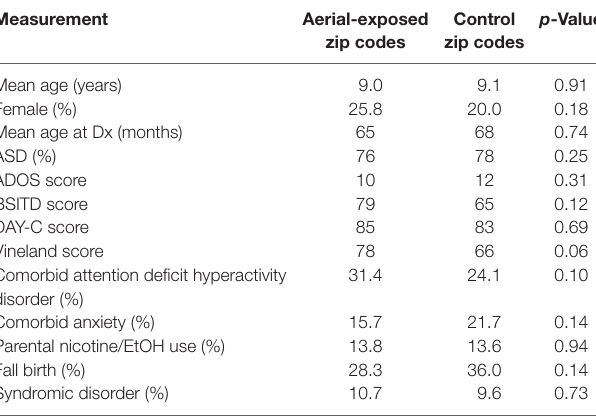
TaBle 6 | clinical characteristics of subjects with asD and DD from aerial-exposed and control zip codes. Measurement aerial-exposed zip